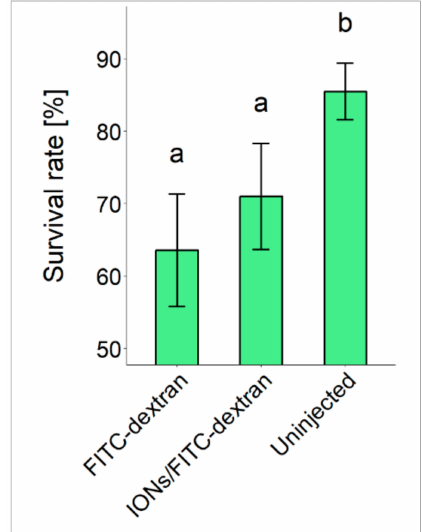
Figure 1. Survival rates of sturgeon embryos injected with FITC-dextran only, IONs / FITC-dextran and uninjected embryos. Di ff erent letters (a and b) above the SD bars represent statistical